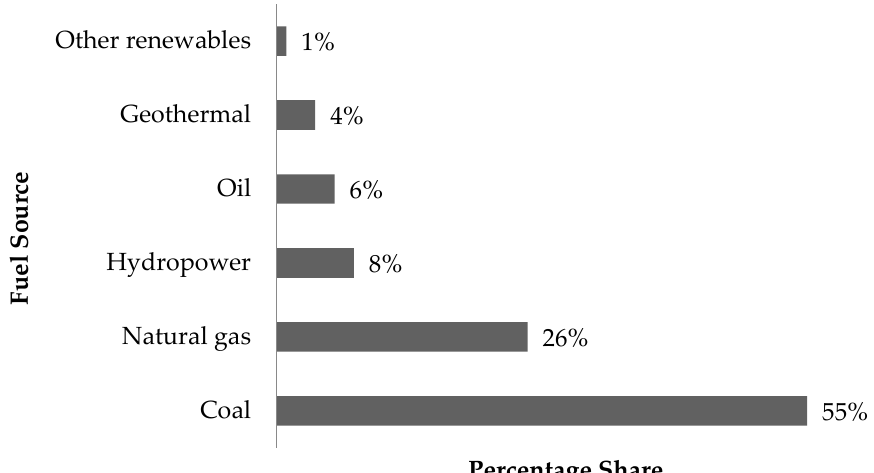
Figure 2. PLN energy sources and their percentage shares [51,52].